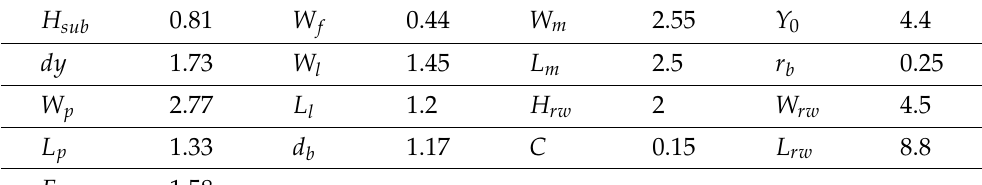
Table 2. Dimensions in millimeters of each designed parameter for the bottom-side transition.